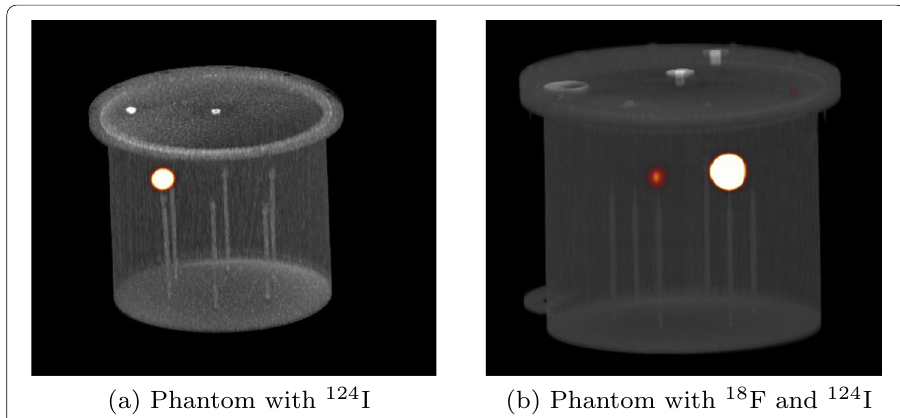
Fig. 11 PET/CT phantom acquisition using a cylindrical Jaszczak Phantom (Data Spectrum Corporation, Durham, NC, USA), the diameter of 21.6 cm and a volume of 6.9 L, with the microspheres (9.5, 12.7, 15.9, 19.1, 25.4, and 31.8 mm